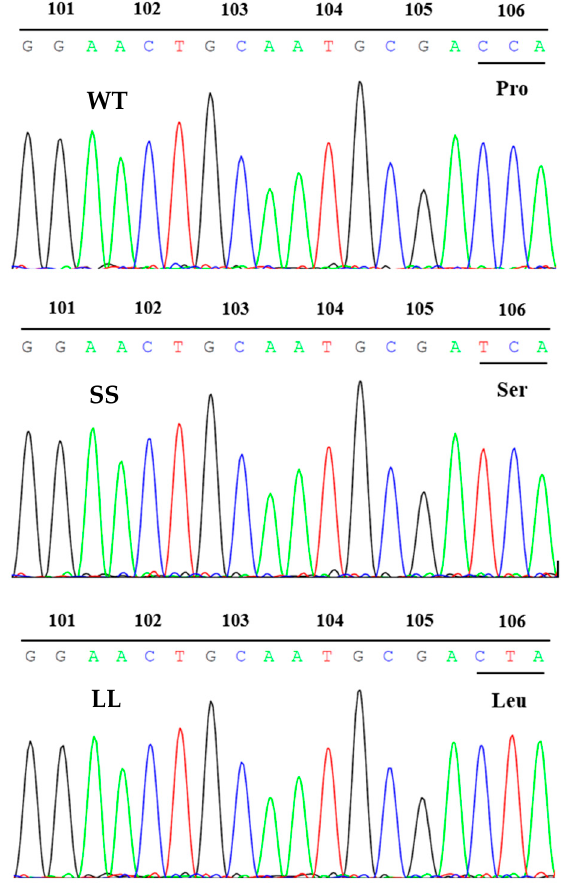
Figure 2. Partial nucleotide sequence results of EPSPS gene for the WT, SS, and LL populations, respectively. A homozygous mutation of Pro106Ser was detected in the SS population and a homozygous mutation of Pro106Leu was identified in the LL population by sequencing chromatograms.